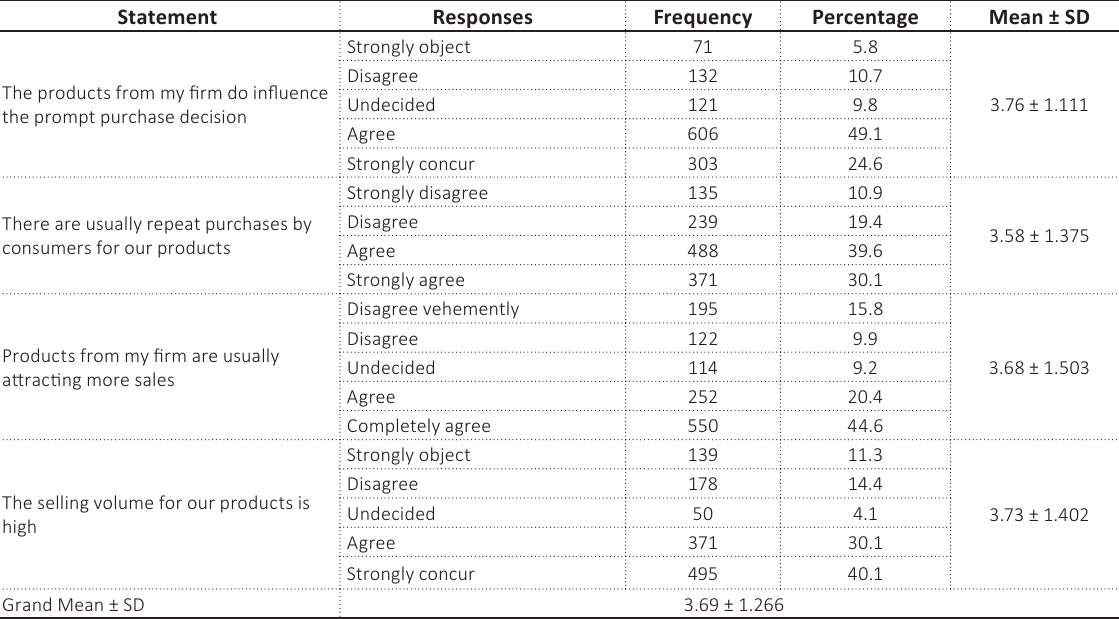
Table 9. Consolidated responses to questions related to the first hypothesis